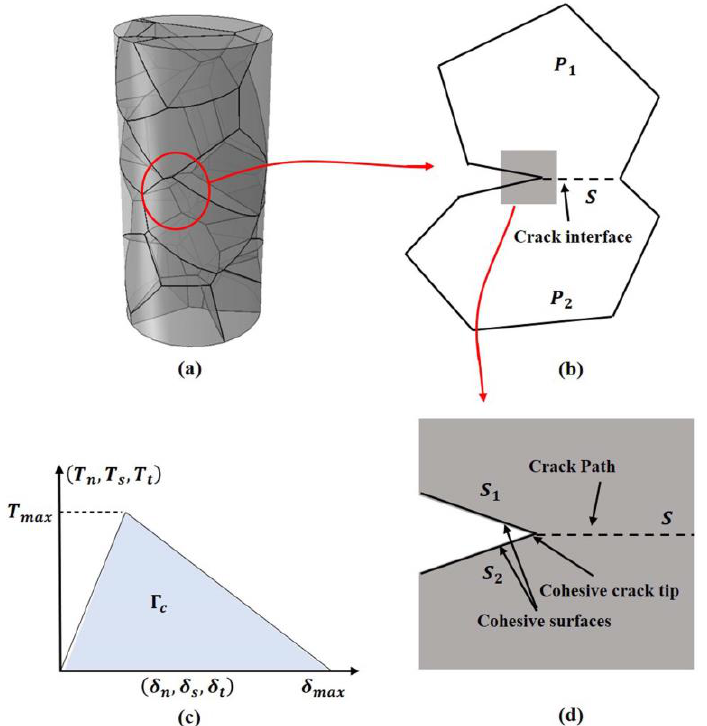
Figure 2. ( a ) Basalt model based on Voronoi random seeds. ( b ) crack propagation along the polyhedral surface. P1 and P2 are two different cross sections of the polyhedra in contact with each other, and s is the initial mutual contact surface. ( c ) Traction separation laws for cracks and damage of the material, where ( T n , T s , T t ) and ( δ n , δ s , δ t ) are the common traction and separation components, and T max and δ max represent the maximum traction force due to damage and the maximum separation displacement at the damage, respectively. ( d ) Local amplification of crack